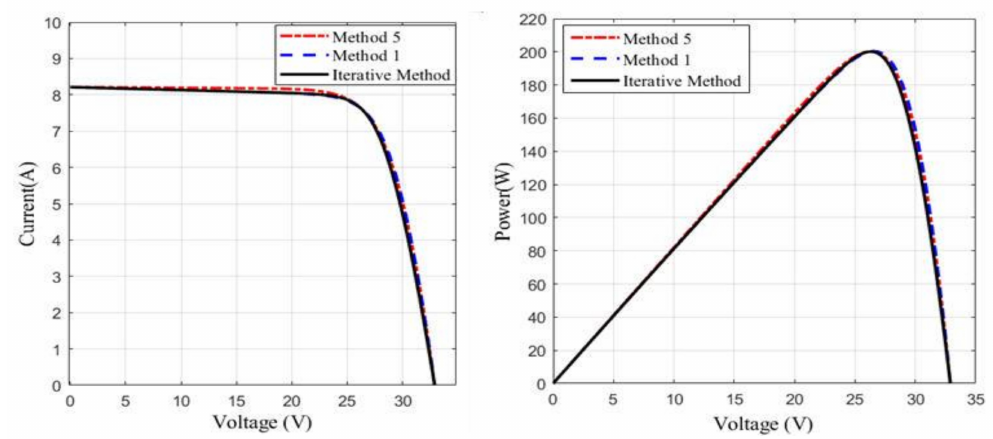
Figure 6. Comparison between the I–V ( left ) and P–V ( right ) curves obtained using Methods one and five with those obtained using numerical method for the KC200GT module.